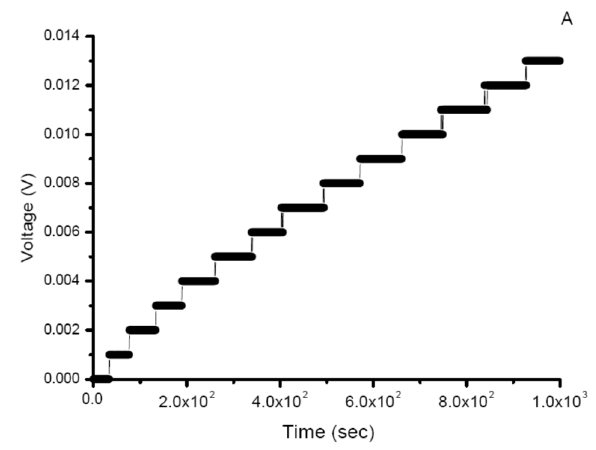
( a ) Figure 3. Cont ( a )